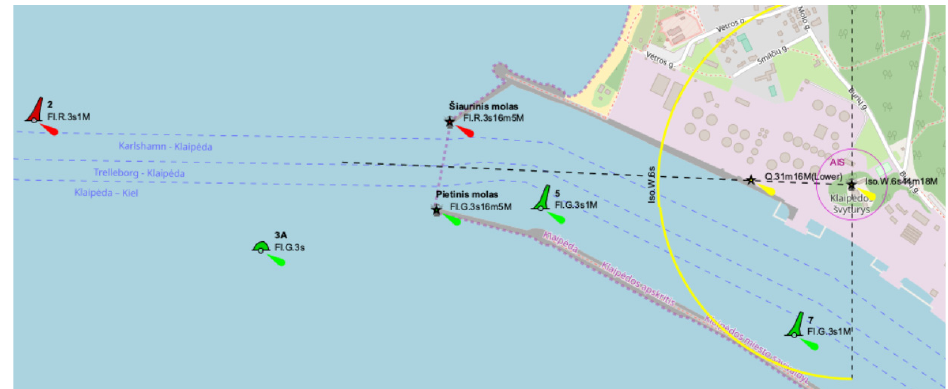
Figure 5. Navigational channel bend of Ś winouj ś cie port to LNG terminal area and ship’s sailing way, where: 013G, 014R, etc. – names of the buoys, Oc.Y.10s11m17M, Oc.Y.10s11m17M – charac- teristics and visibility distance of the lighthouses [21].